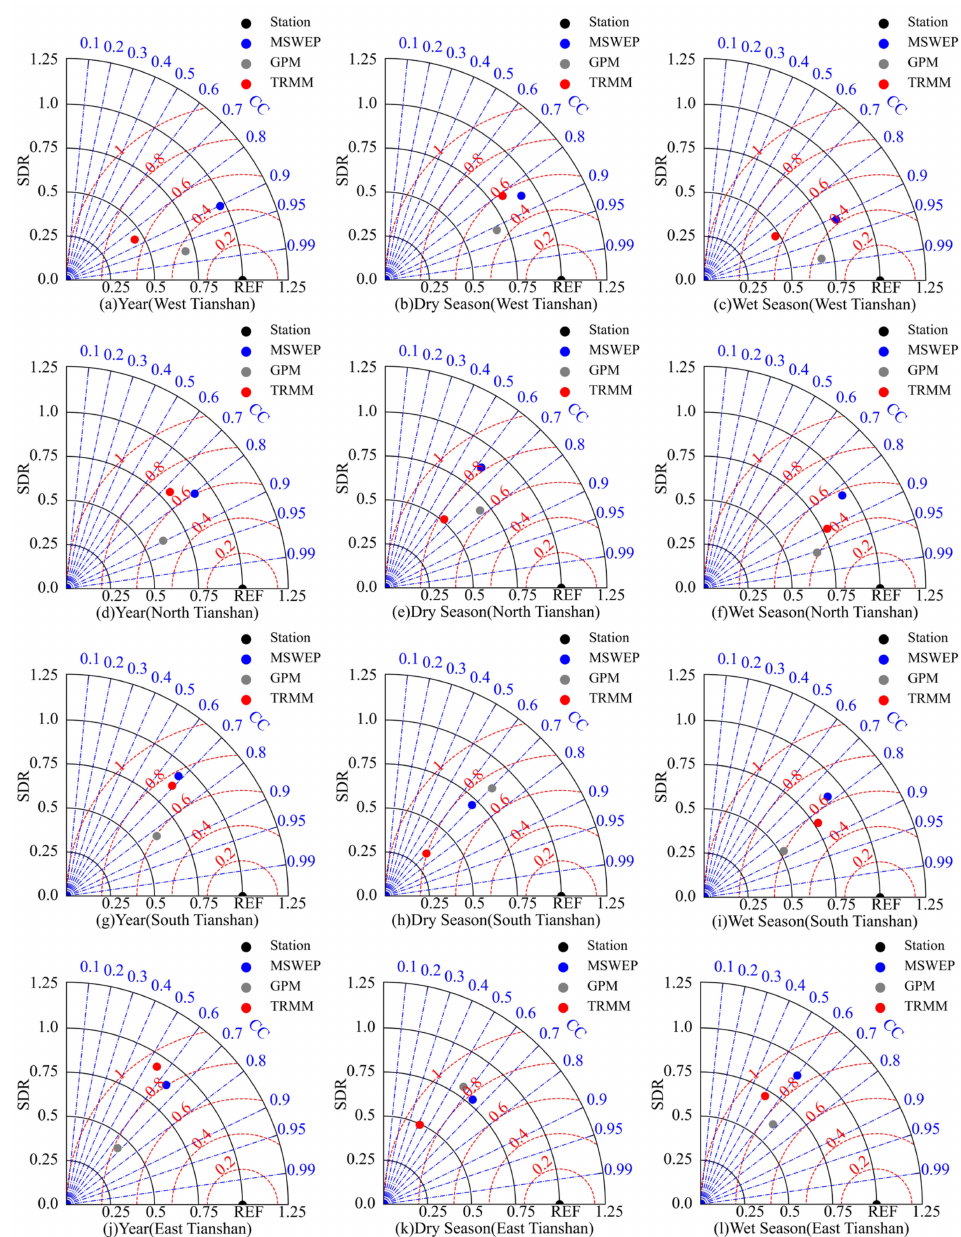
Figure 2. Evaluation indicators Taylor diagram of precipitation products in different regions of annual scale ( a , d , g , j ), dry season ( b , e , h , k ) and wet season ( c , f , i , l ). West Tianshan ( a – c ); North Tianshan ( d – f ); South Tianshan ( g – i ); East Tianshan ( j – l